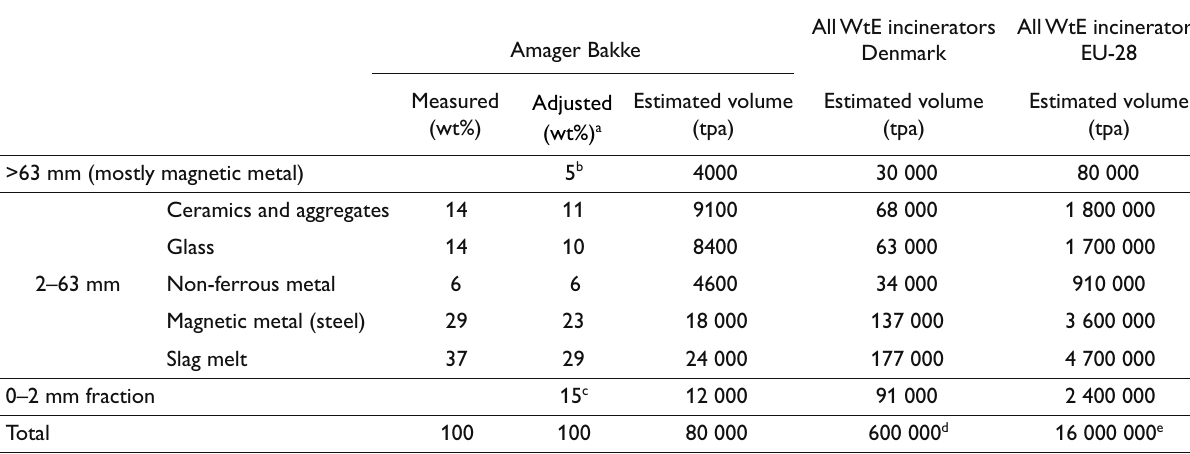
Table 1. Estimated annual resource volume produced by Amager Bakke waste-to-energy (WtE) plant. Potential volume in Denmark and the EU-28 is extrapolated from the distribution among raw material groups observed at Amager